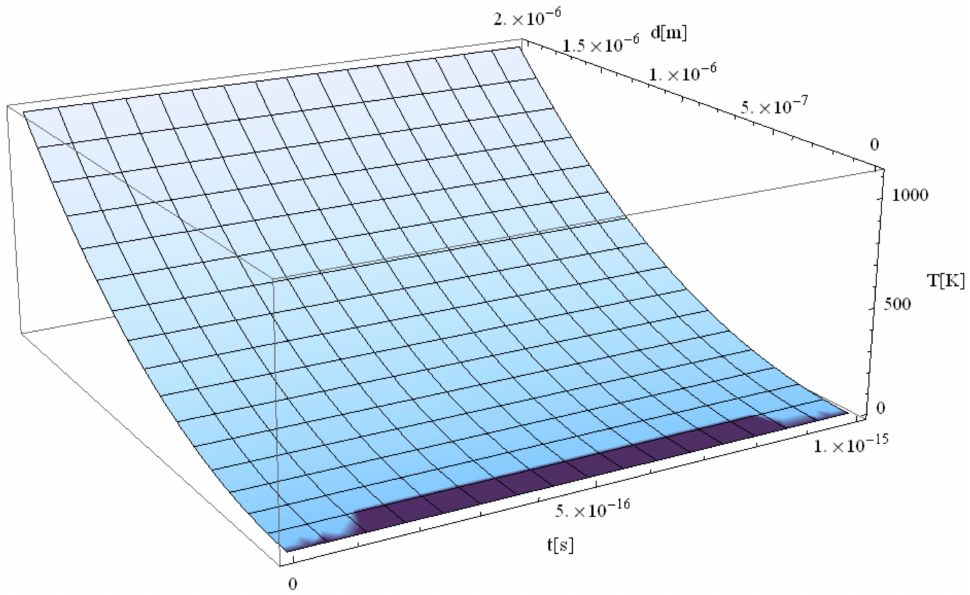
Figure 8. Electron temperature versus radius during 1 fs simulation after irradiation with a 100 as laser pulse applied to an Au particle.